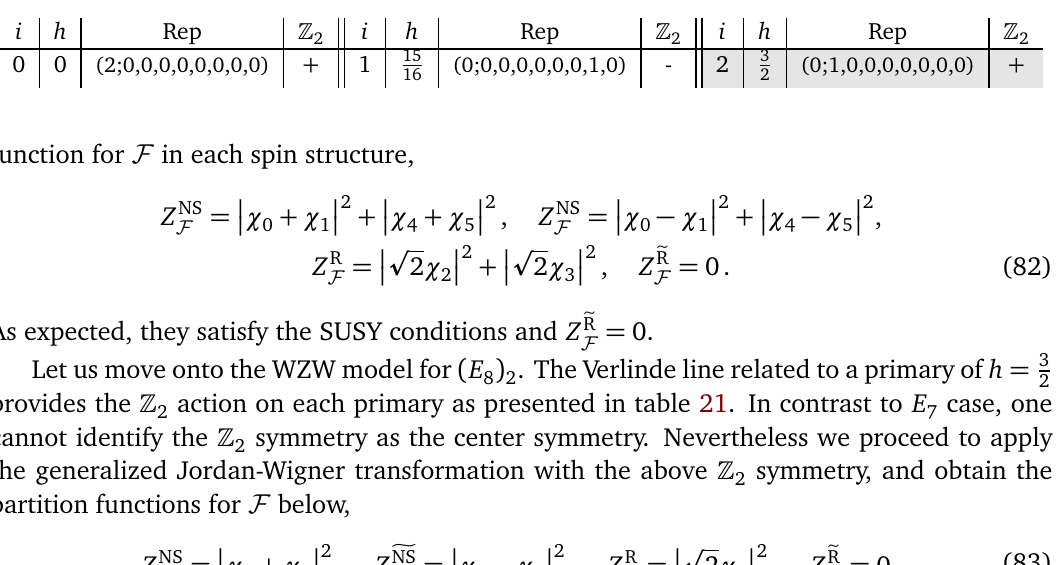
) Table 21: ( E : primaries labeled by i are characterized by weights h and E 8 2 ( τ ) . We highlight the primary related to the center symmetry Their characters are denoted by χ i (cid:90) . The partition functions for F in the NS and R sectors are also 2